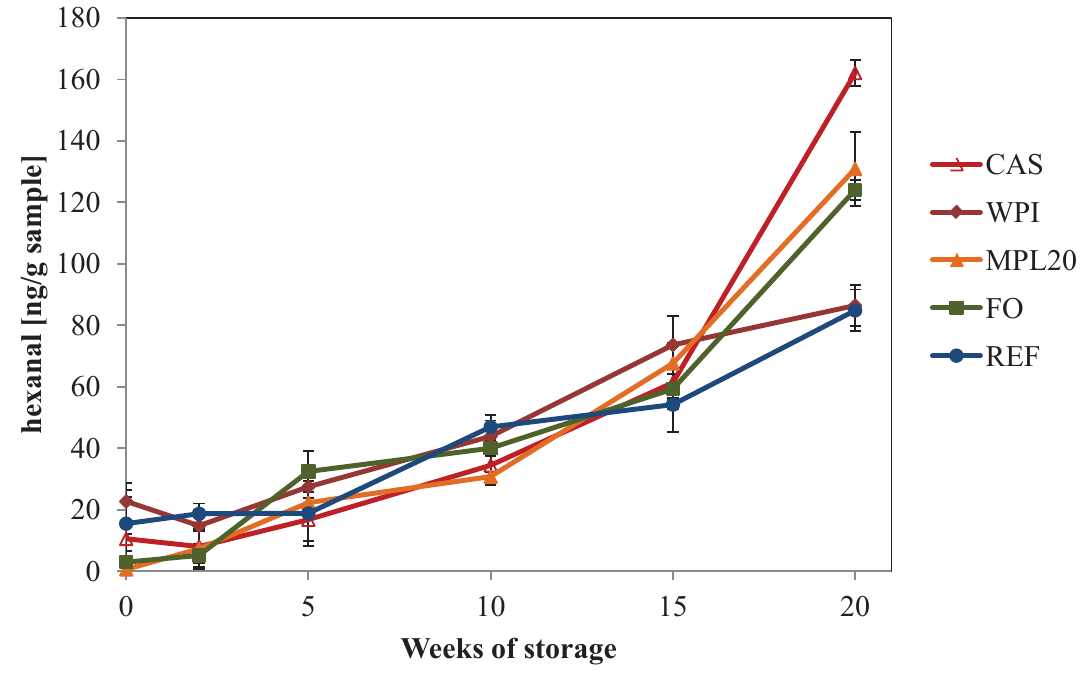
Figure 3. The development in hexanal concentrations (ng/g sample) in cream cheeses with fish oil added as neat oil (FO), or in a delivery emulsion prepared with different emulsifiers (CAS, WPI or MPL20) compared to a reference cheese without fish oil (REF) during storage for 20